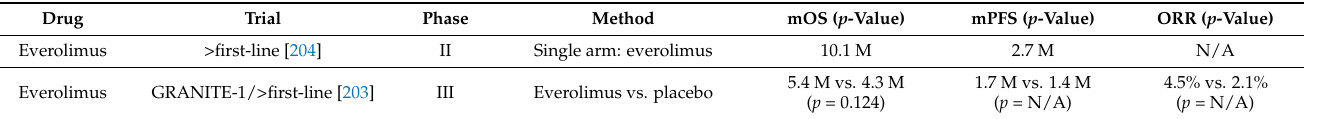
Table 10. Phase II and III trials of therapies targeting mammalian target of rapamycin mOS, median overall survival; mPFS, median progression-free survival; HR, hazard ratio; M, months; ORR, objective response